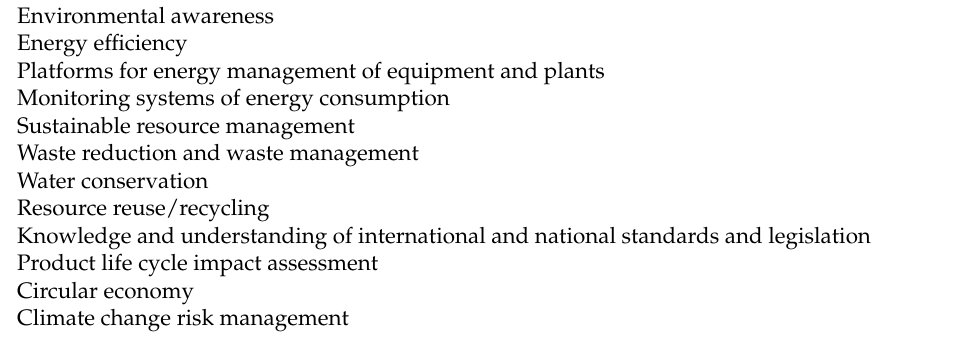
Table 4. List of selected future green skills for the renewable energy sector workforce. Reprinted from Akyazi, T.; Goti, A.; Oyarbide-Zubillaga, A.; Alberdi, E.; Carballedo, R.; Ibeas, R.; and